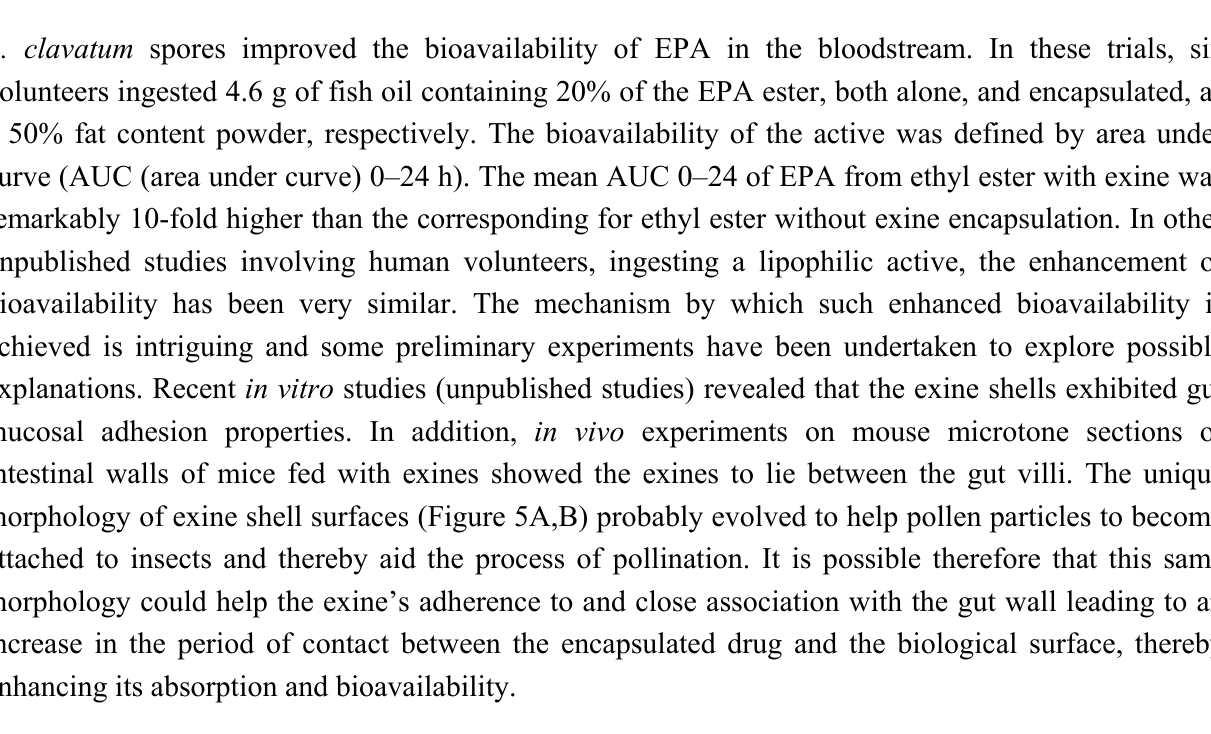
Figure 5. ( A ) Microcapsules extracted from sunflower pollen; and ( B ) microcapsules extracted from Ambrosia trifida